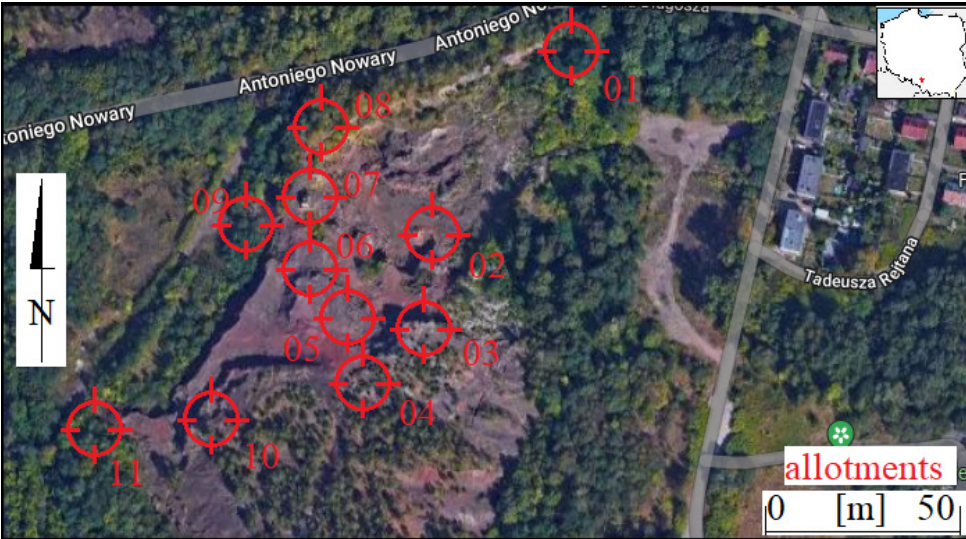
Figure 2. Location of sampling points for heap, soil and plants (on Google Maps).